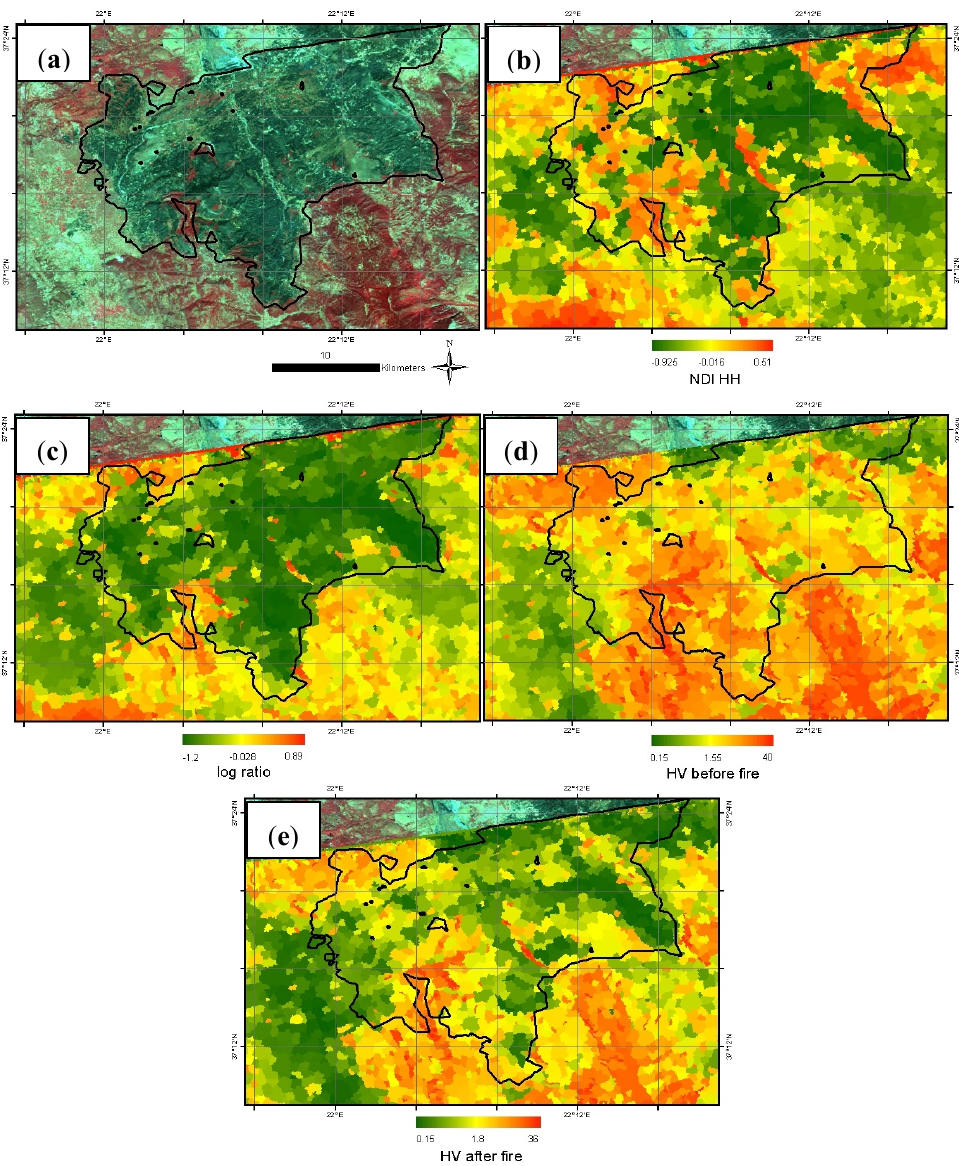
Figure 3. Visualizations of different object features for mapping burned areas ( a ) The burned area in the Peloponnese as depicted by Satellites Pour l’Observation de la Terre (SPOT) imagery (R: Near-infrared (0.78–0.89 µm), G: Red (0.61–0.68 µm), B: Green (0.50–0.59 µm)). The black perimeter is the reference fire perimeter, which is generalized for viewing purposes. Healthy vegetation is depicted in red, burned areas in black, and non-vegetated areas in white. ( b ) Visualization of the normalized difference index of objects (NDI) using the HH (H: Horizontal) polarization data of the Advanced Land Observing Satellite (ALOS) Phased Array type L-band Synthetic Aperture Radar (PALSAR) images acquired before and after the fire ( c ) Visualization of the log-ratio feature using the HV (V: Vertical) polarization data of the PALSAR images acquired before and after the fire, ( d ) Visualization of the HV data of the PALSAR image acquired before the fire, ( e ) Visualization of the HV data of the PALSAR image acquired after the